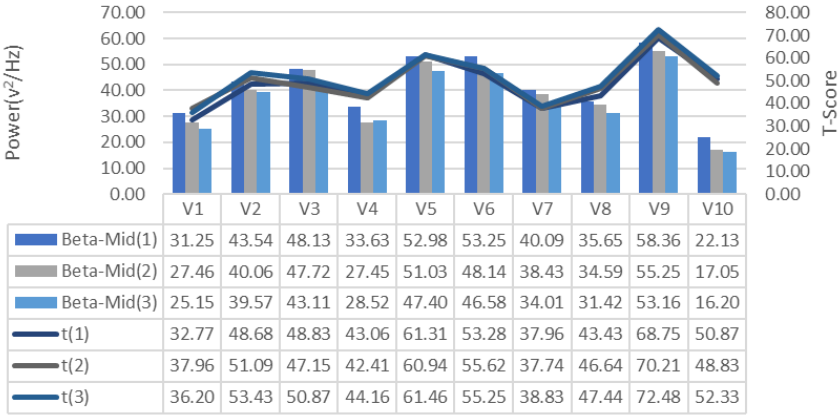
Figure 9. GDTS per round on track with Beta-Mid band power game performance (T-Score) rela- tionship.